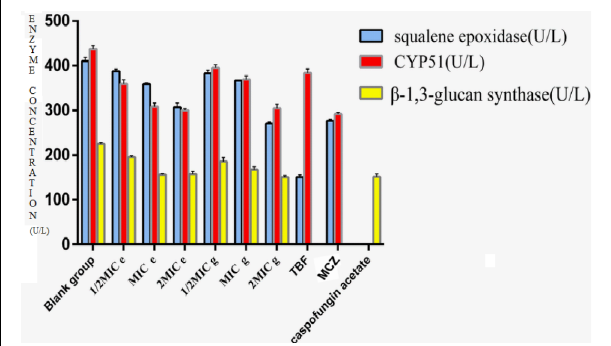
FIGURE 4 | Effect of compounds e and g on CYP51, squalene epoxidase, and β -1,3-glucan synthase. (MIC e -value, 20 µ g/mL; MIC g -value, 10 µ g/mL; MCZ, miconazole nitrate; TBF, terbinafine hydrochloride.)